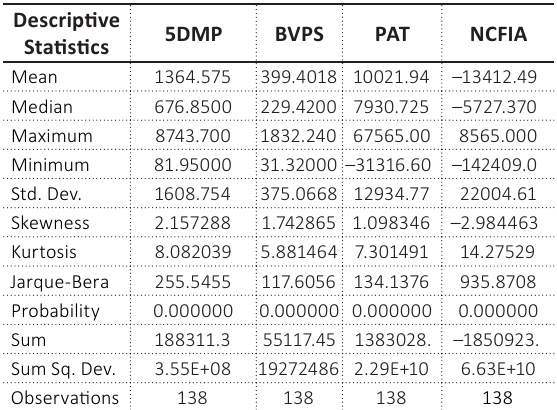
Table 2. Descriptive statistics, post-Ind AS